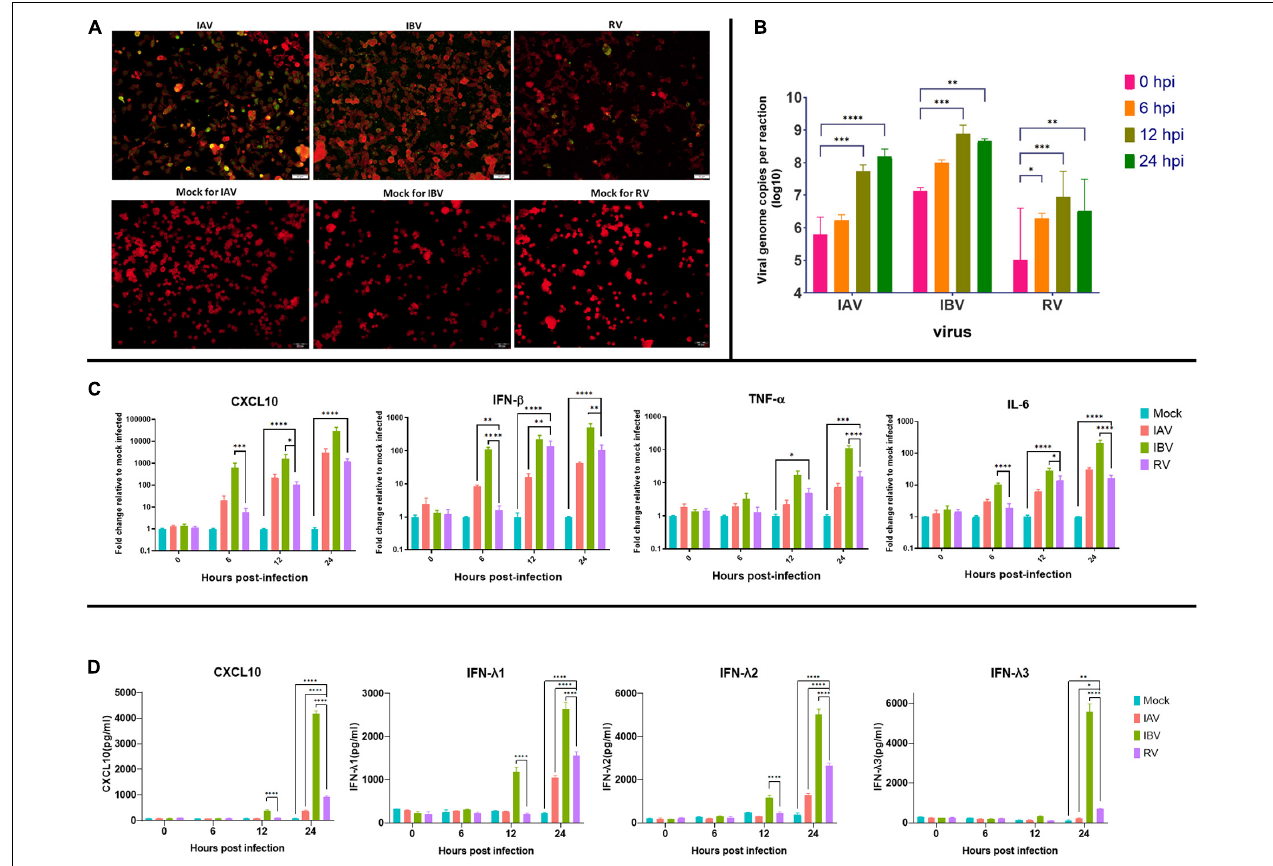
FIGURE 1 | Infection of influenza A virus (IAV), influenza B virus (IBV) or rhinovirus (RV) in Calu-3 cells. (A) Calu-3 cells were infected with IAV, IBV, or RV at 1 MOI. IAV, IBV, and RV antigen expression was determined at 24 h post infection. Antigen expression was determined using fluorescein-tagged murine monoclonal antibodies against IAV, IBV, or RV. Mock-infected cells stained with respective monoclonal antibodies against IAV, IBV, or RV are shown in the bottom row. White scale bar = 50 µ m. (B) Multicycle growth assay. Calu-3 cells were infected with IAV, IBV, or RV at 1 MOI. Viral load was determined using real-time RT-qPCR. (C) Cytokine and chemokine expression of Calu-3 cells infected with IAV, IBV, or RV at 1 MOI. Cytokine expression was determined using real time RT-PCR. GAPDH was used for normalization of gene expression. (D) Cytokine and chemokine protein expression of Calu-3 cells infected with IAV, IBV, or RV at 1 MOI. Protein expression was determined using ELISA. Bars (B,C) represent means (error bars show standard error of mean) of duplicates in two independent experiments. Bars (D) represent means (error bars show standard error of mean) of triplicates in one independent experiment. Statistical significance (for B–D ) was calculated with two-way ANOVA. ( ∗ P < 0.05, ∗∗ P < 0.01, ∗∗∗ P < 0.001, ∗∗∗∗ P < 0.0001). hpi, hours post infection; MOI, multiplicity of